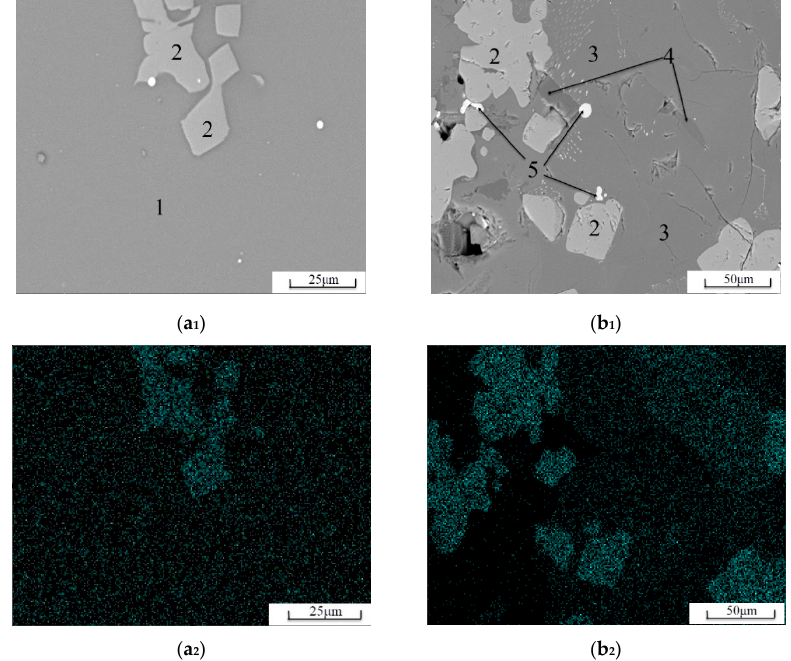
Figure 3. SEM images of Ti surface scanning of high-titanium slag. ( a 1 ) SEM image of TS; ( a 2 ) Ti surface scanning of TS; ( b 1 ) SEM image of TM; ( b 2 ) Ti surface scanning of